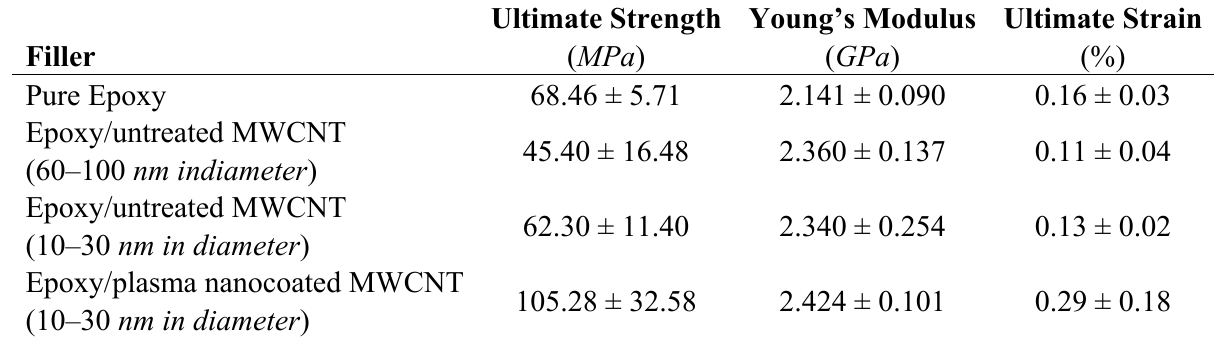
Table 1. Tensile test results of pure epoxy (Epon 81C), and its nanocomposites reinforced with 1.0 wt % untreated MWCNTs and plasma nanocoated MWCNTs.